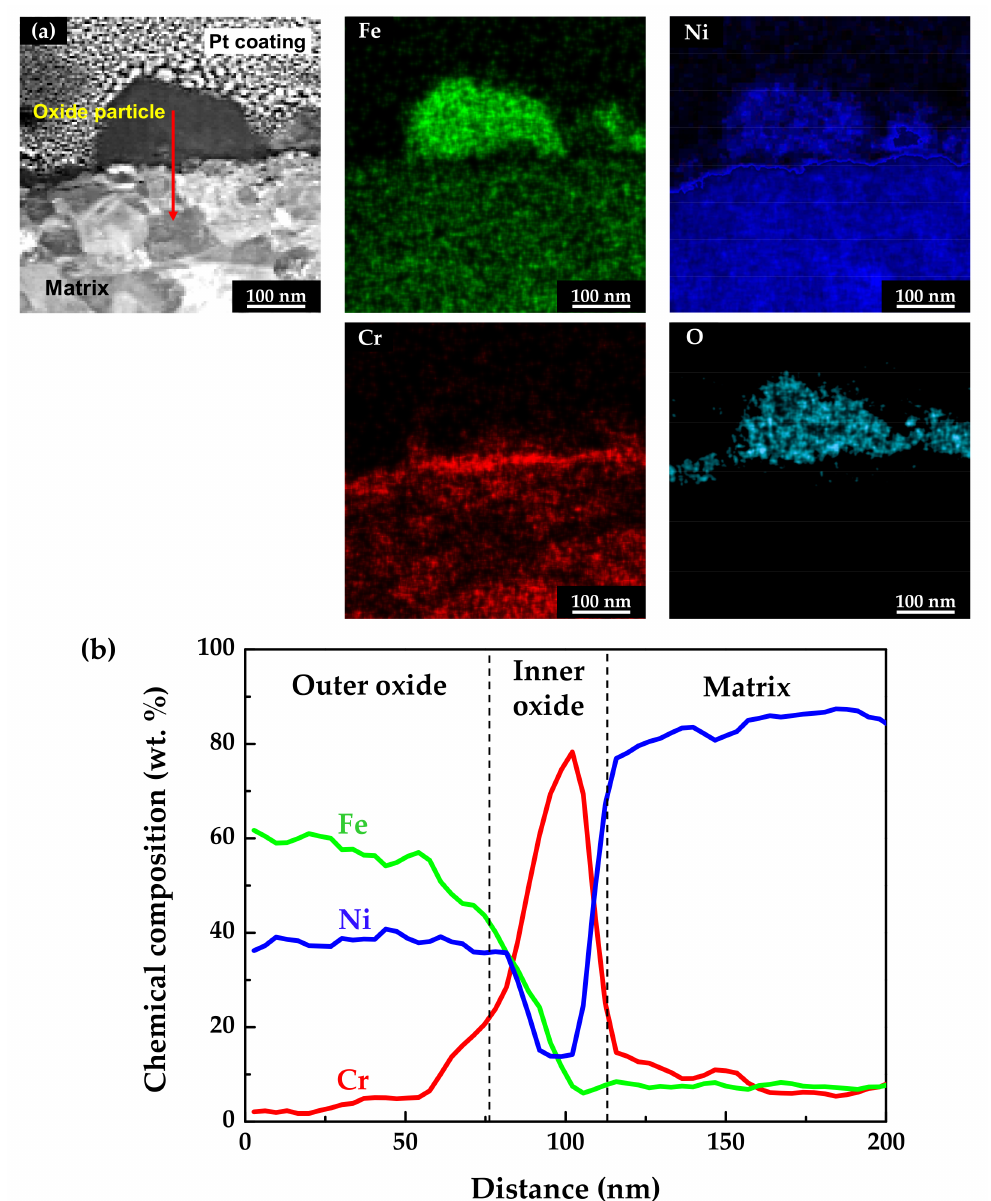
Figure 5. STEM image and EDS analyses of oxide films formed on Alloy 600 specimens under the stress-free condition: ( a ) EDS elemental maps and ( b ) EDS elemental line